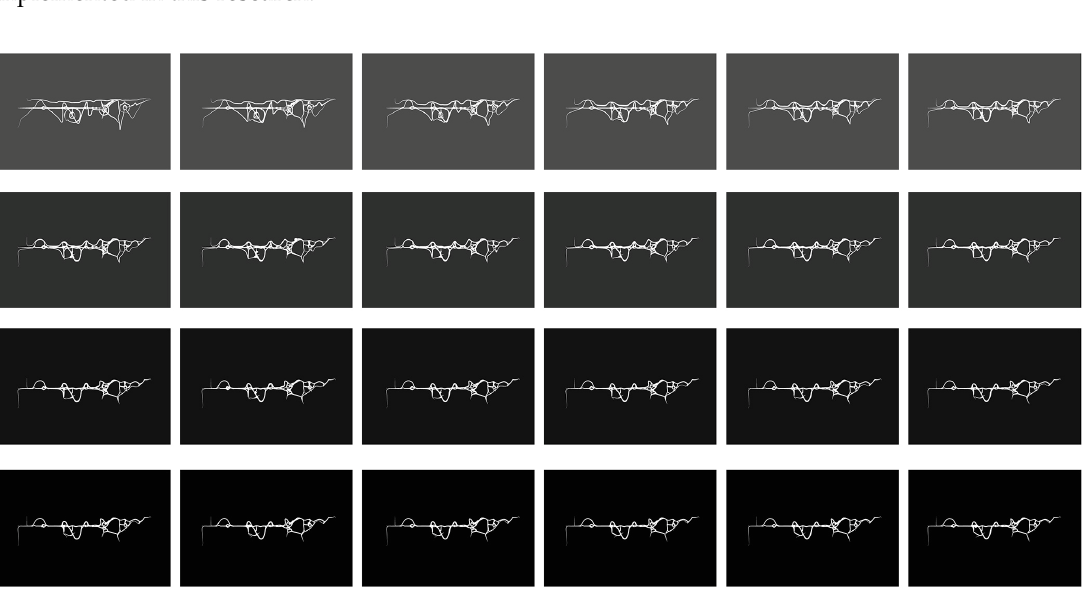
Figure 2. Stabilization sequence of the self-organized